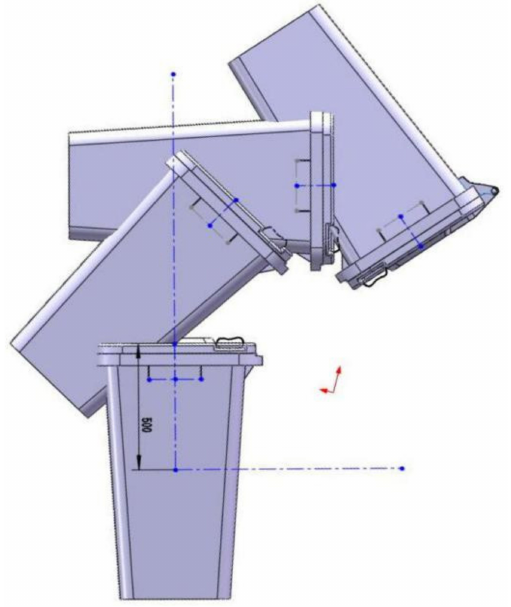
Figure 15. Trajectories of the trash